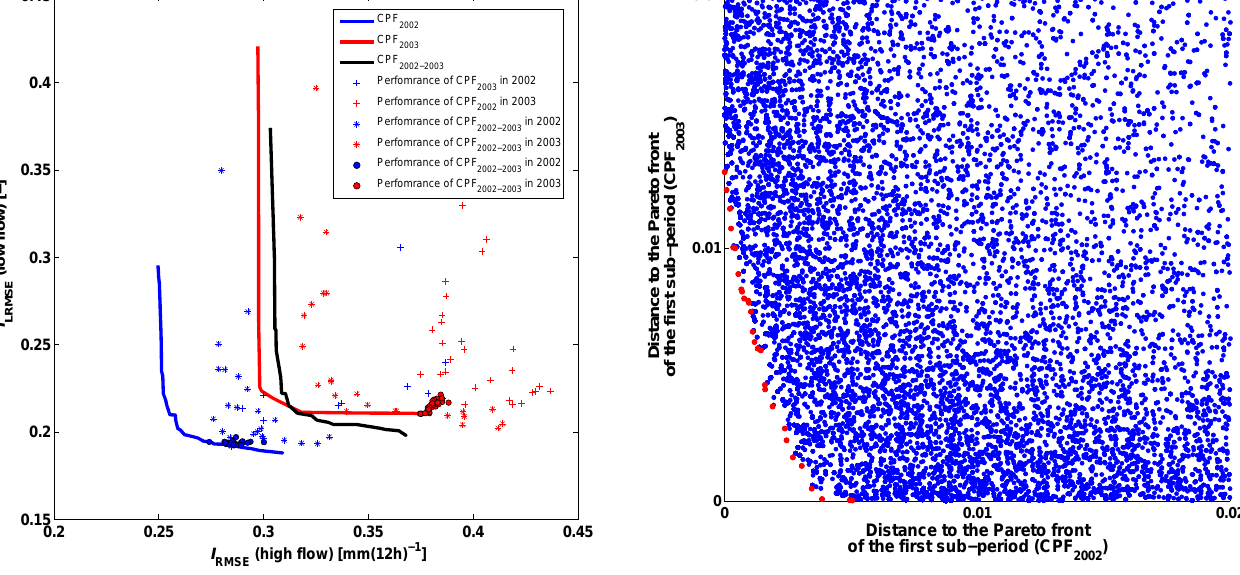
Fig. 4. The calibration Pareto fronts based on 2002, 2003 and 2002– 2003 (CPF 2002 , CPF 2003 , CPF 2002 − 2003 ) are illustrated by blue, red and black respectively. The blue and red crosses show the performance of CPF 2002 members in 2003 and the performance of CPF 2003 members in 2002 respectively. The blue and red as- terisks illustrate performance of CPF 2002 − 2003 in 2002 and 2003 respectively. The blue and red dots illustrate the performance of MDPF 2002 − 2003 in year 2002 and 2003 respectively.